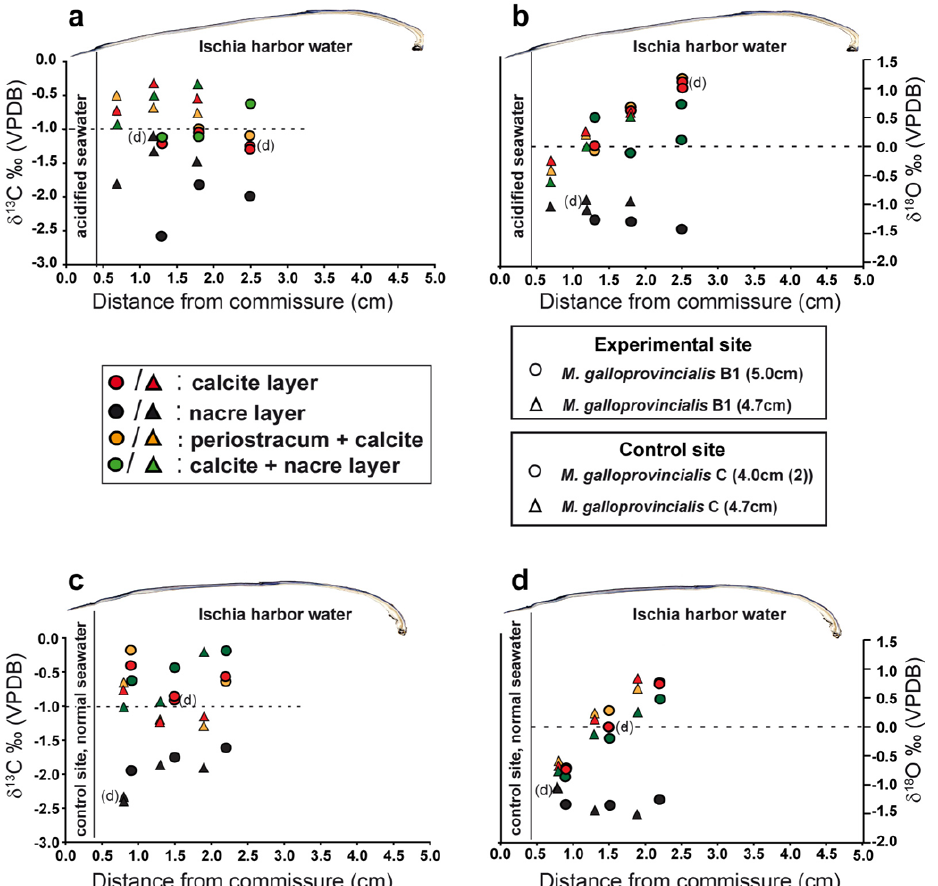
Fig. 9. Differential carbon and oxygen isotope ratios representing shell layer and mixed samples (legend and Fig. 1a) of four specimens of M. galloprovincialis B1 and C (a–d) plotted against distance from commissure. Different specimen are characterized by their different shell length and experimental site, e.g. M. galloprovincialis C (4.0cm, 2) refers to a specimen with a shell length of 4cm that was dislocated to control site C. Isotope values from two specimen from the same site, differentiated by their length, are labelled by a circle and a triangle, respectively. ( a through d ) Mytilus galloprovincialis shell isotope values from experimental site B1 (a, b) and control site C (c, d) . Colour code represents different layers analyzed. Note considerable differences in isotope values from different shell layers. Aragonitic (nacreous) layer isotope data were normalized against calcite isotope values using the equation of Rubinson and Clayton (1969) for δ 13 C and that of Tarutani et al. (1969) for δ 18